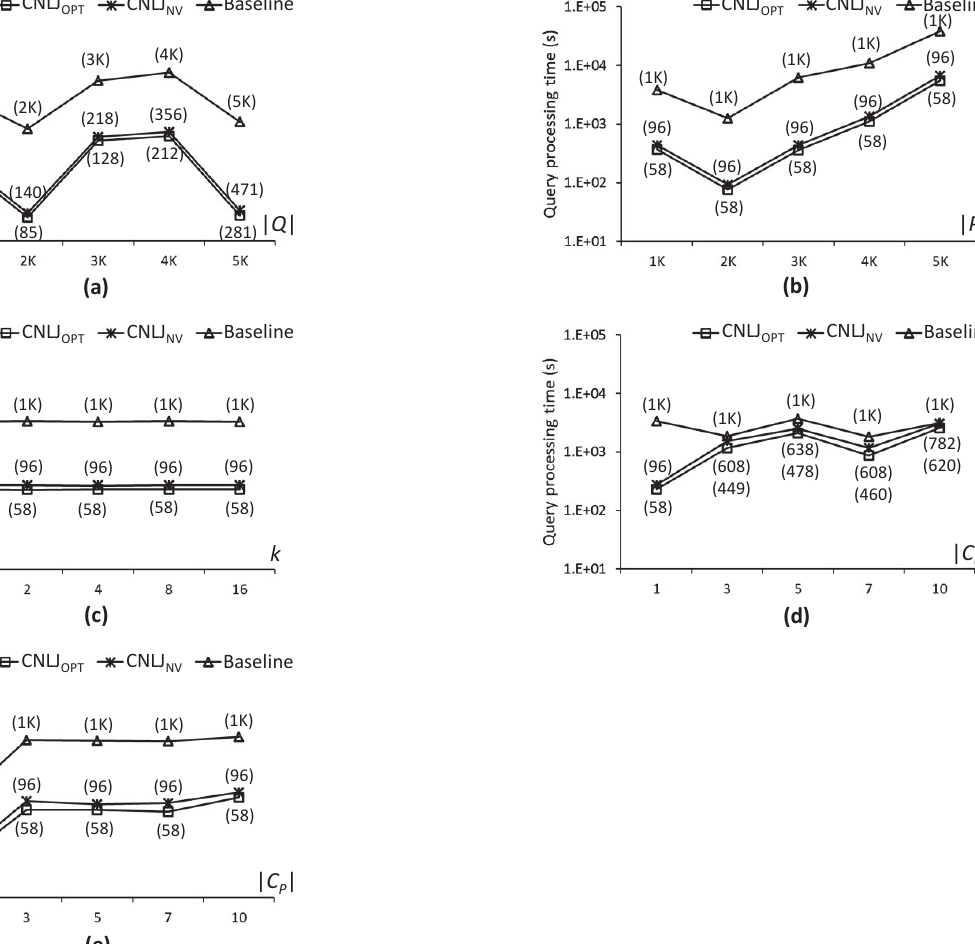
(cid:12) (cid:12) (cid:12) C Q (cid:12) ≤ 10; ( e ) 1 ≤ | C P | ≤